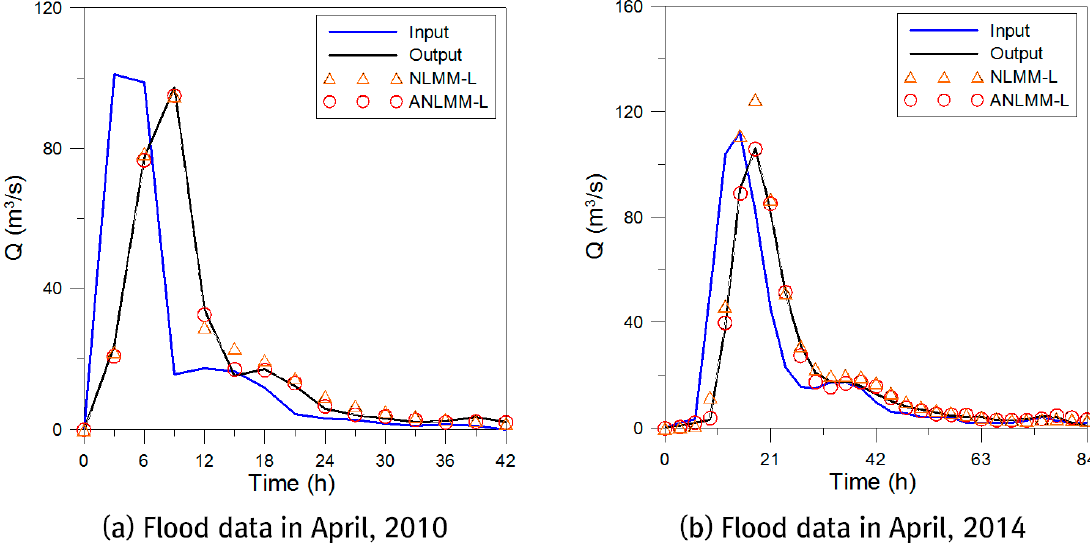
Figure 7. Results of prediction in Daechung flood data: ( a ) Flood data in April, 2010; ( b ) Flood data in April, 2014.